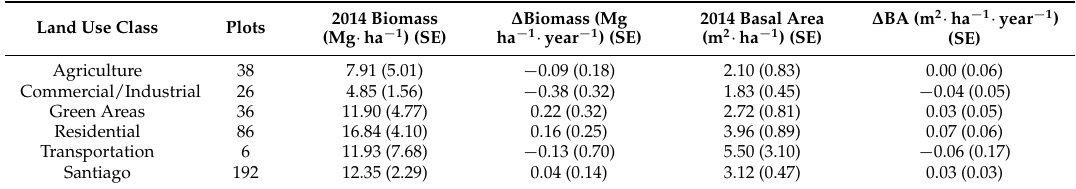
Table 4. Mean tree biomass, change in tree biomass ( ∆ Biomass) during 2002 to 2014, mean basal area, and change in basal area ( ∆ BA) during 2002 to 2014 in Santiago, Chile.